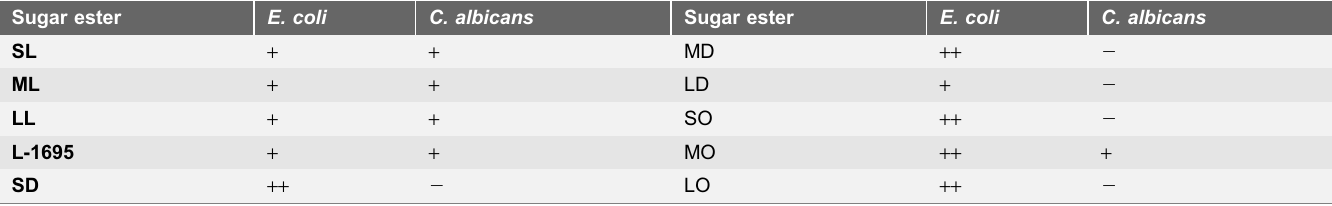
Table 3. Screening of antimicrobial properties of a series of sugar monoesters and L-1695 at a concentration of 3000 m g/mL a . Sugar